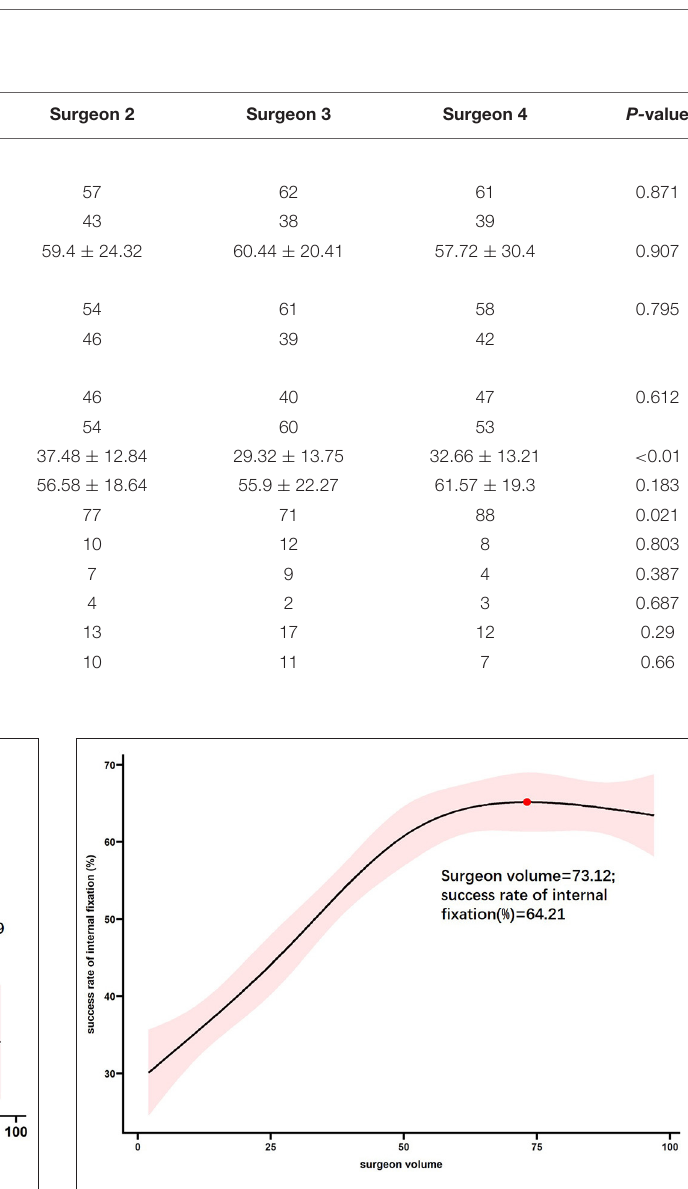
FIGURE 1 | Probability of operation time for supracondylar fractures according to surgeon volume.